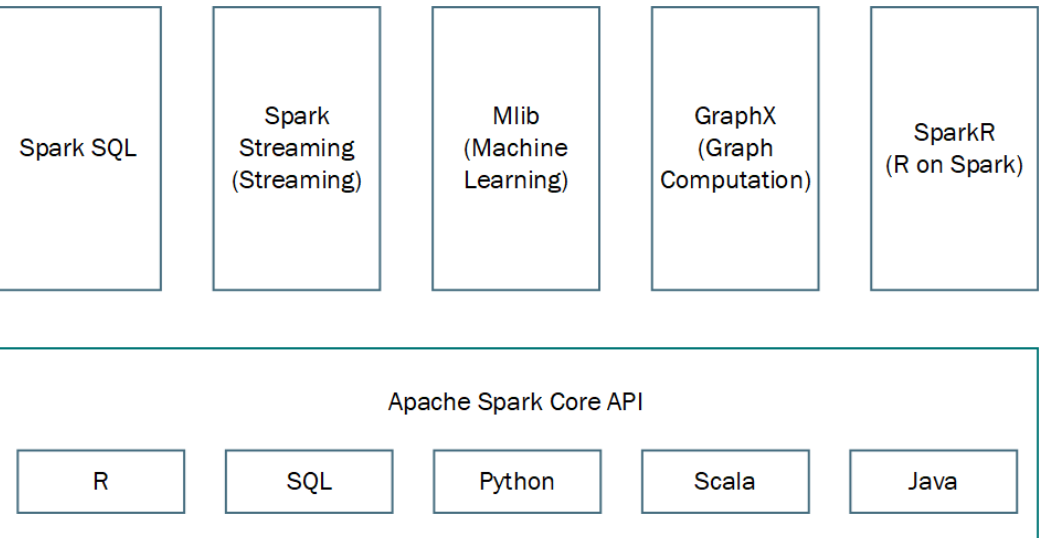
Figure 7. Apache Kafka main